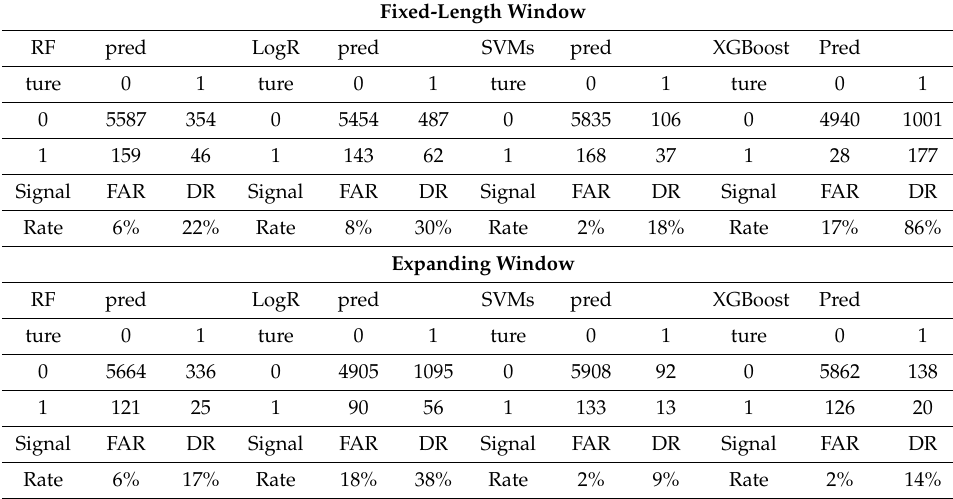
Table 7. Classification accuracy table for